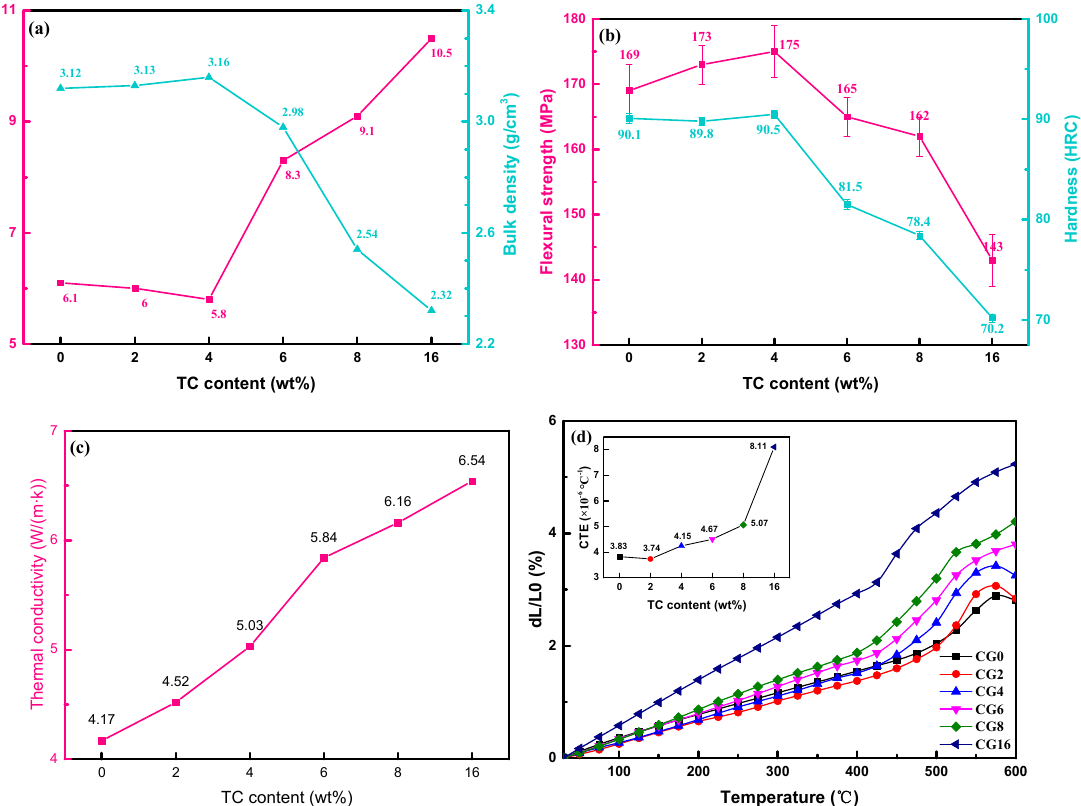
Figure 11. Physical properties of TC composites as a function of TC alloy mass fractions sintered at 950 °C for 1 h: ( a ) porosity and bulk density, ( b ) flexural strength and Rockwell hardness, ( c ) thermal conductivity and ( d ) CTE (30 to 300 °C).